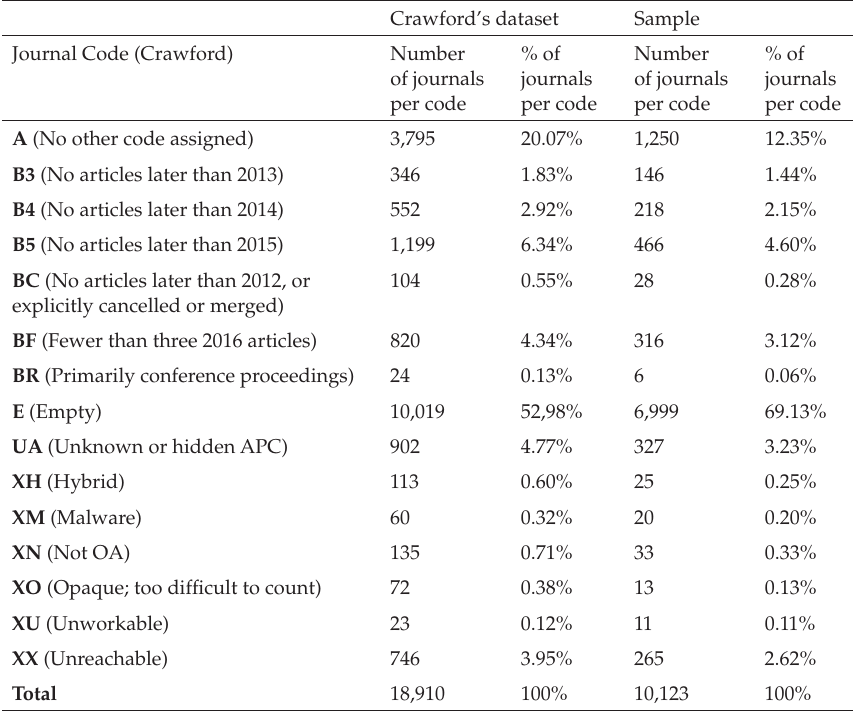
Table 1: Comparative proportions of journals per code in Crawford’s dataset and in our